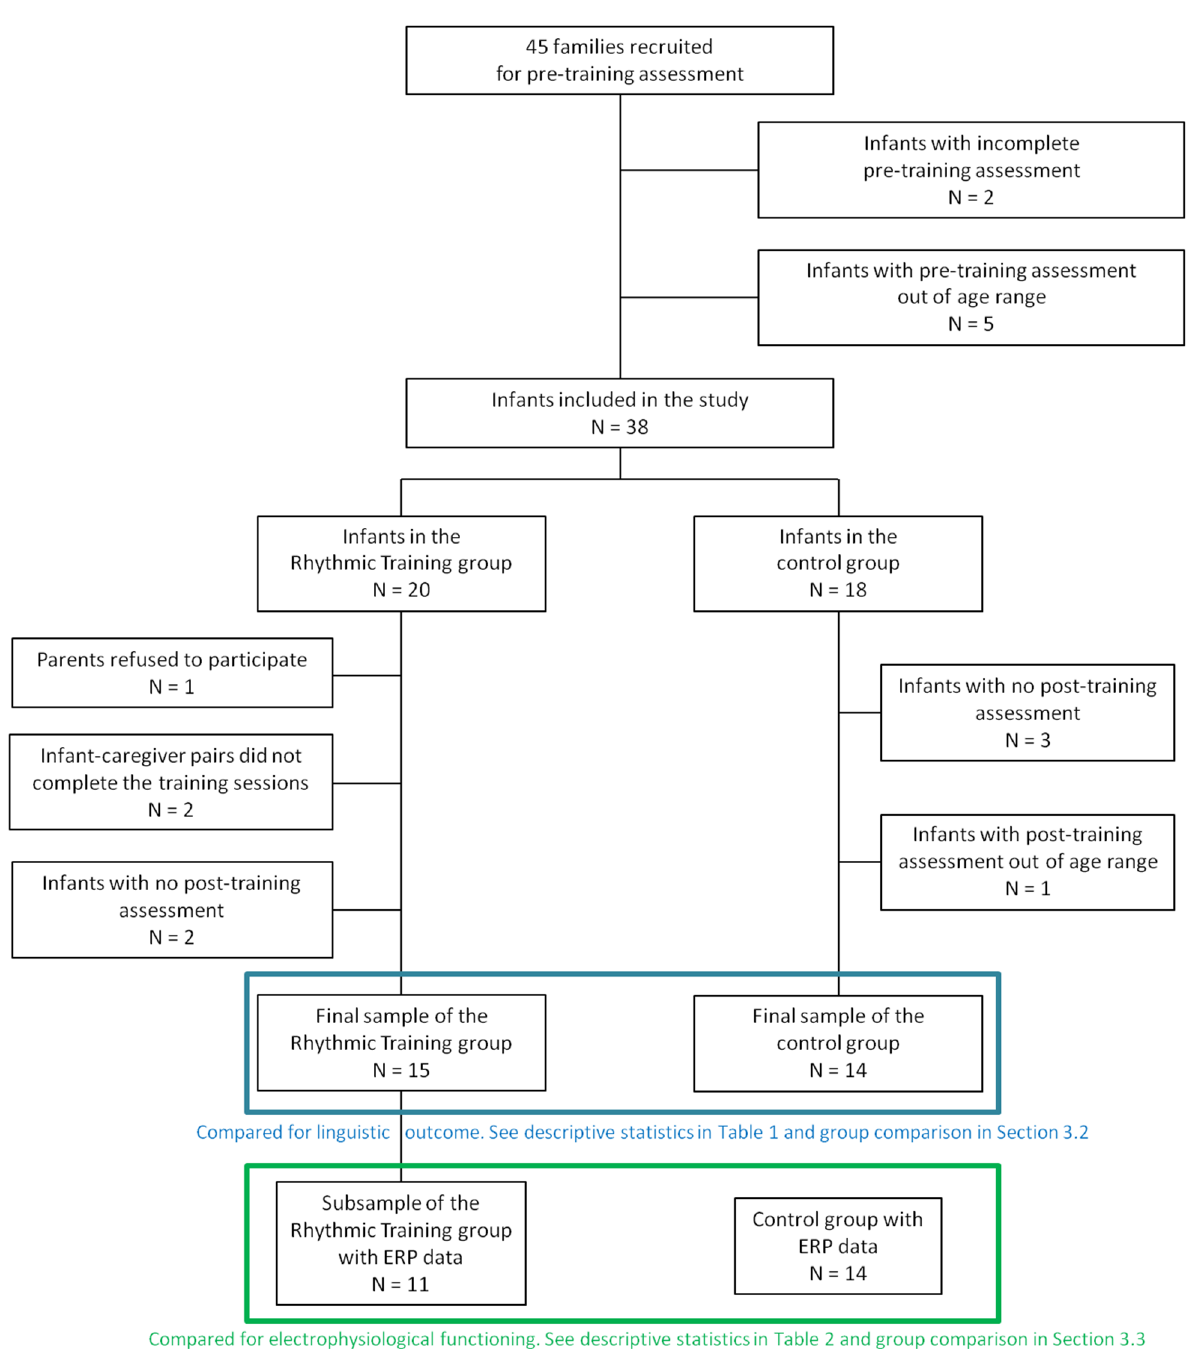
Figure 1. Flow diagram of the families who participated in the study. The two groups did not differ in terms of sex ( χ 2 (1, N = 29) = 0.829, p = 0.362) or sociodemographic characteristics (Table 1A).